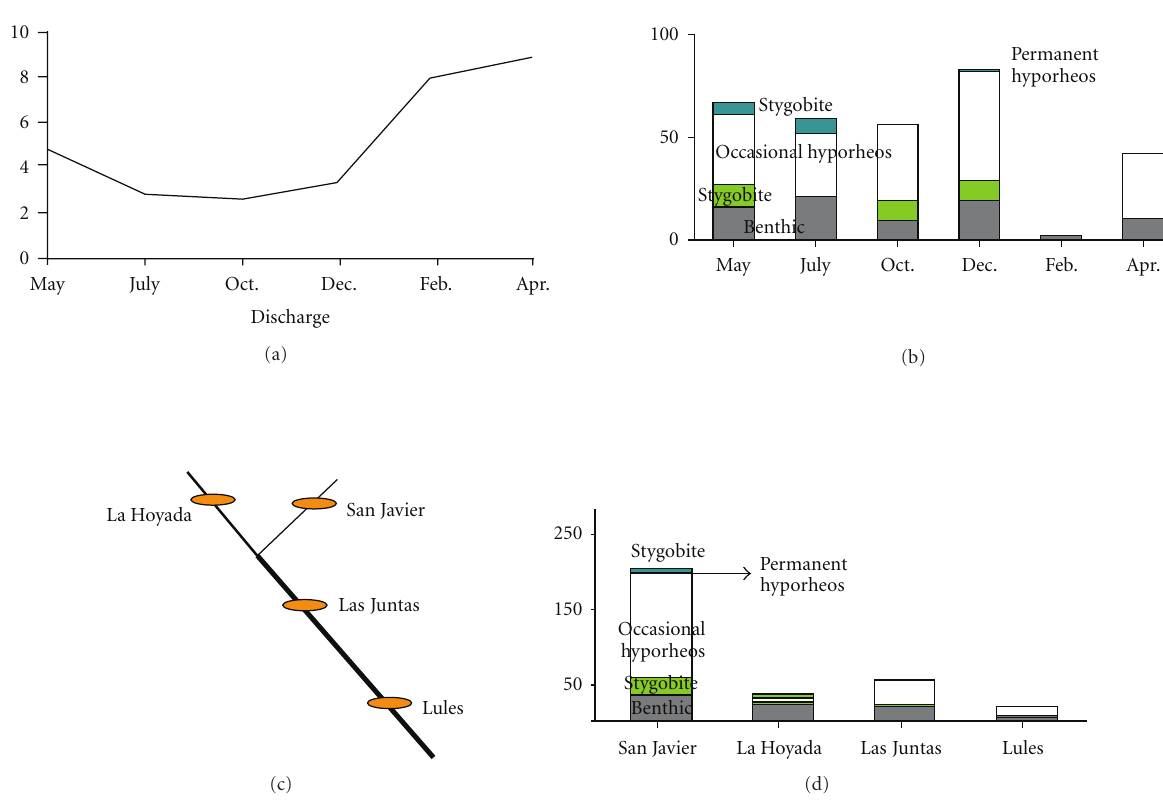
Figure 4: Example of use of the Hydrachnidia functional classification (Lules streams, Tucum´an, Argentina). Left-top: discharge (m 3 s − 1 ) Lules River during the year. Left-bottom: esquematization of the sampled rivers and sites.